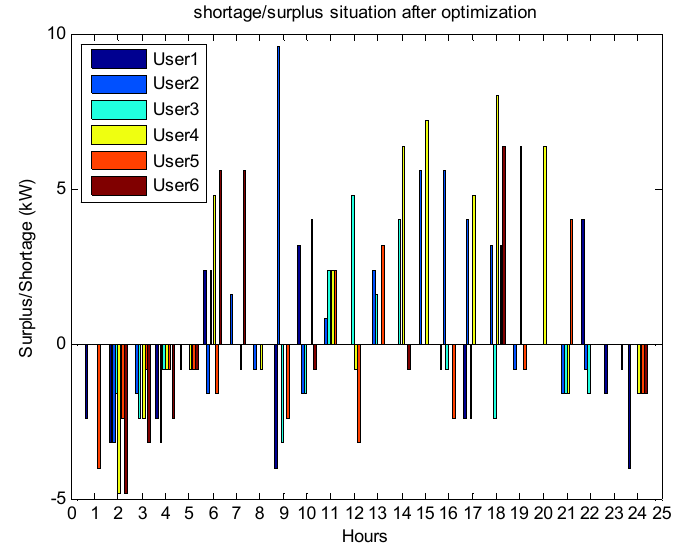
Figure 9. Optimized shortage and surplus energy according to multiple criteria approach.